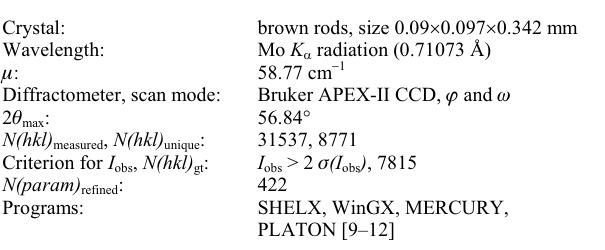
Table 1. Data collection and